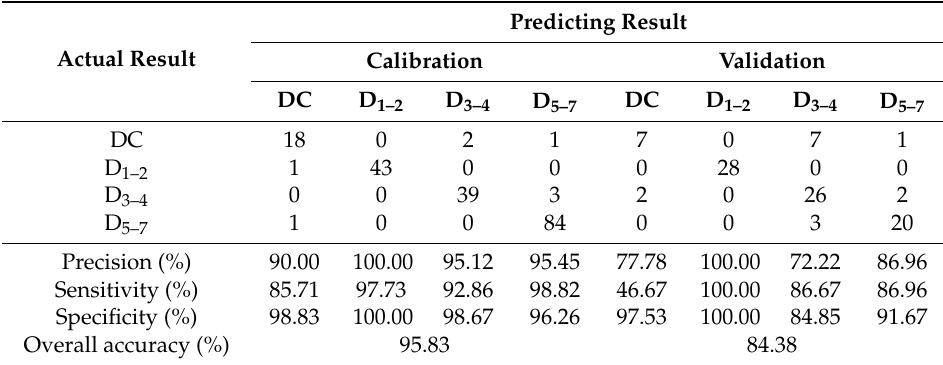
Table 4. Confusion matrix of calibration and validation set of the best model based on the mixture of kernels orientated with germ up and down.